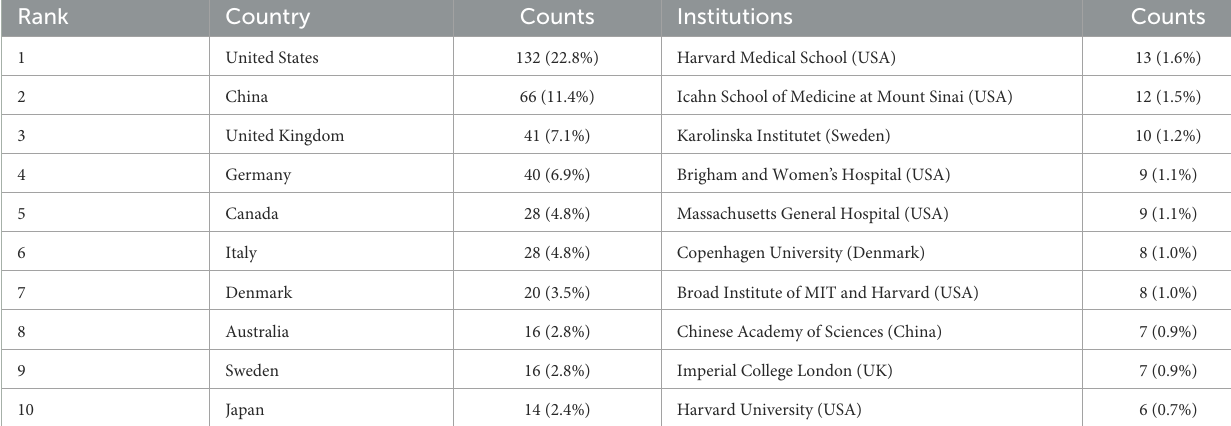
TABLE 1 The top 10 countries and institutions on the research of omics in